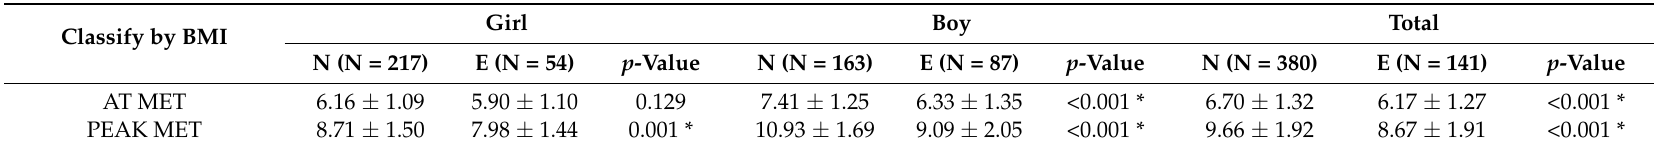
Table 3. Cardiopulmonary function between subjects of excess and normal adiposity under different classifications. Classify by